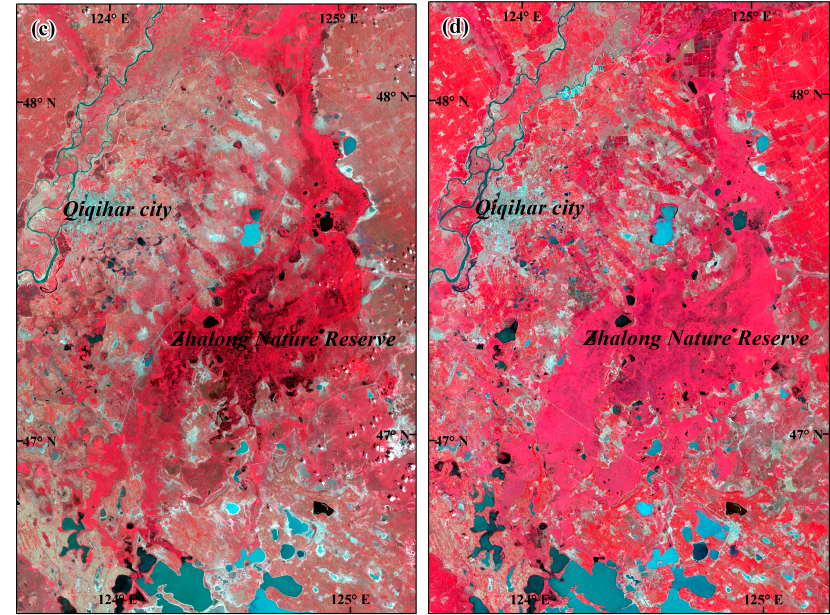
Figure 2. Zhalong Nature Reserve images ( a ) Landsat2 MSS on 1977183, RGB = 321; ( b ) Landsat5 TM on 1985194, RGB = 432; ( c ) Landsat 7 ETM+ on 2002185, RGB = 432 and ( d ) Landsat 8 OLI on 2016200, RGB = 543.